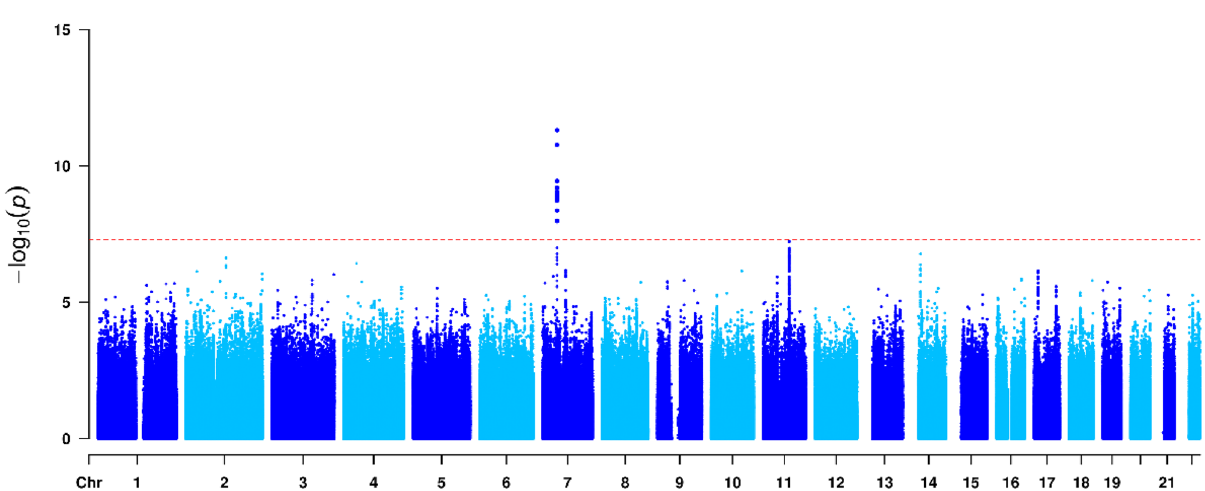
Figure 5. Manhattan plot visualizing genome-wide results from the vQTL analysis of PP. Dots denote the SNPs in the genome-wide vQTL analysis, whose P values on a negative log 10 scale are plotted against their physical positions. The dashed line represents the genome-wide significance level (P = 5 × 10 −8